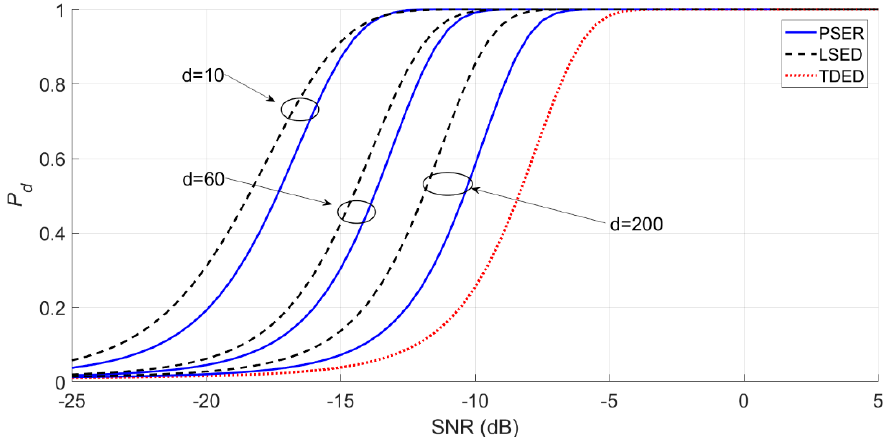
Figure 6. Detection probabilities of the PSER and LSED when the sub-band bin number varies ( N = 512; d = 10, 60, and 200; P f = 0.01; and a = 1).